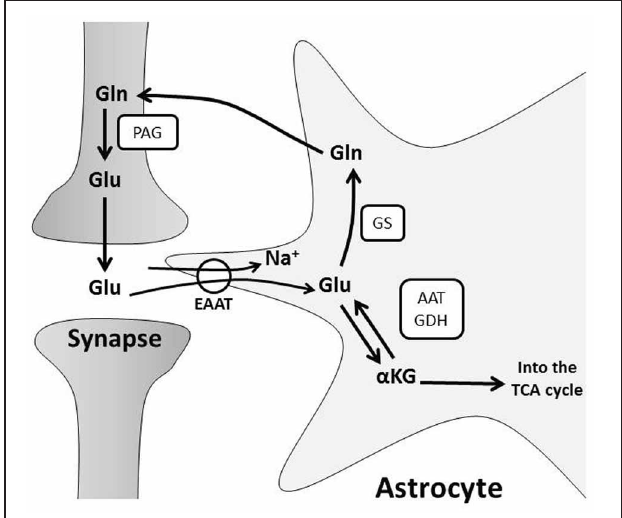
FIGURE 1 | The glutamate-glutamine cycle. Glutamate (Glu) from pre-synaptic neurons stimulates post-synaptic neurons, and the signal is terminated by uptake of Glu from the synaptic cleft into astrocytes. Glu is primarily transported into astrocytes through Na + -dependent excitatory amino acid transporters, EAATs. This disrupts the astrocyte Na + gradient and energy is consumed by the Na + /K + ATPase to restore ionic concentrations. Glu is converted to: (a) glutamine (Gln) via glutamine synthase (GS) or (b) alpha-ketoglutarate ( α -KG) by glutamate dehydrogenase (GDH) or aspartate aminotransferase (AAT) for subsequent oxidative metabolism in the TCA cycle. Gln is shuttled to neurons for glutamate production by phosphate-activated glutaminase (PAG) and the resulting Glu is repackaged in vesicles for further synaptic